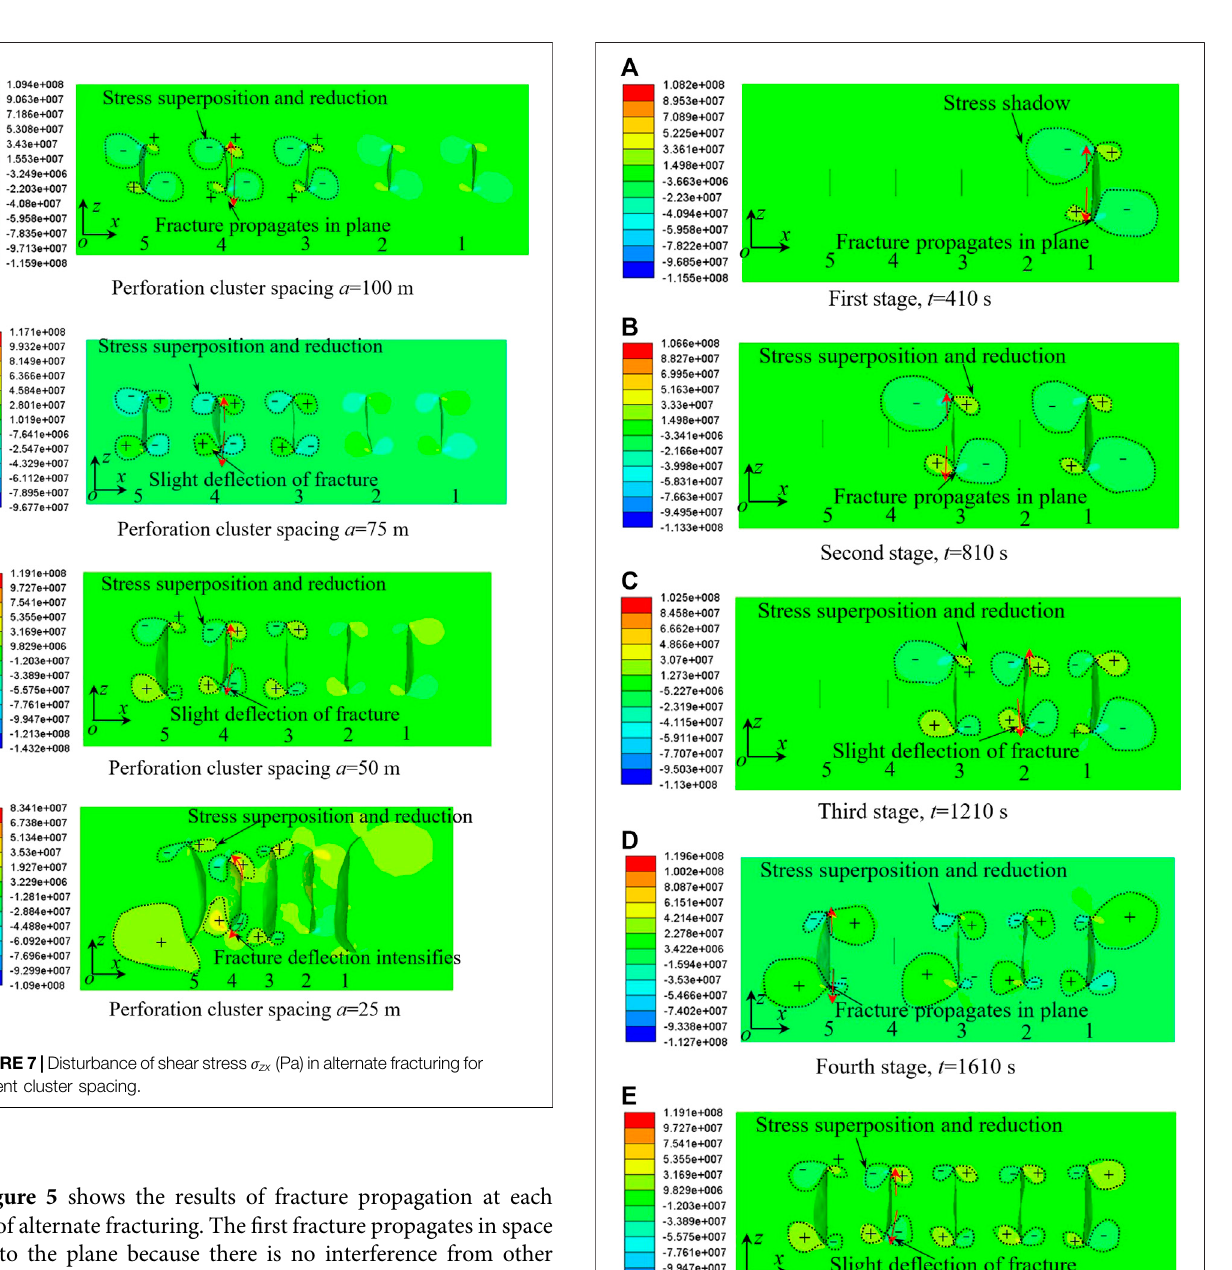
Frontiers in Built Environment |